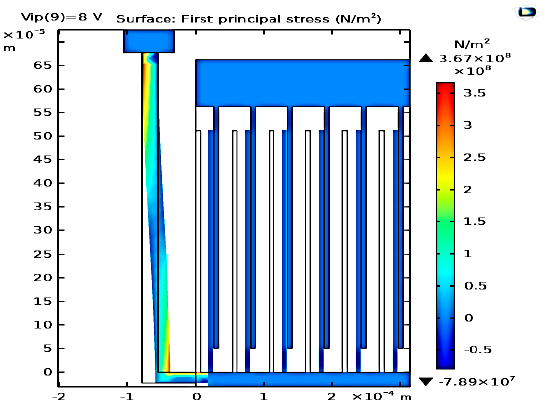
Figure 6. The converter stress analysis is due to the input vibration signal.